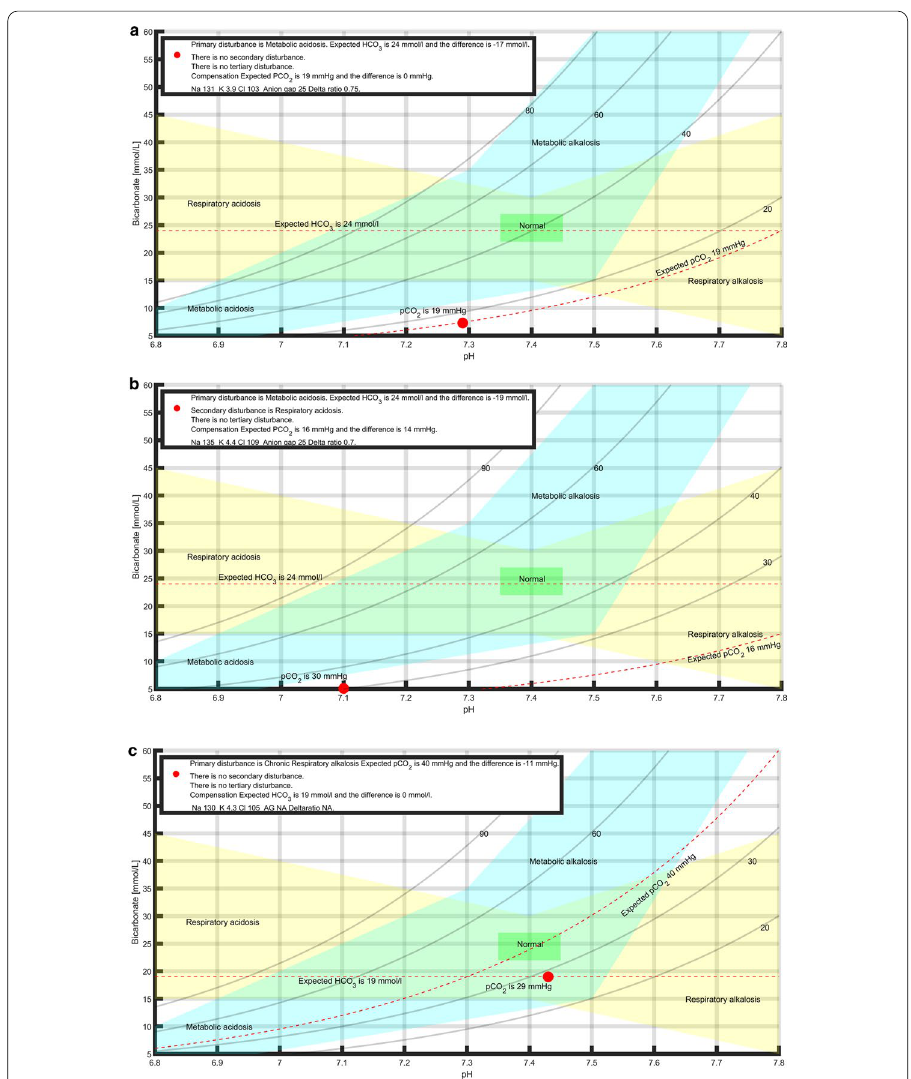
Fig. 1 A Primary disturbance is a metabolic acidosis and the deviation from baseline is 17 mmol/L. − The compensation is full with a hyperventilation resulting in a pCO 2 of 19 mmHg. The script uses Boston formulas. The graphic output shows the low bicarbonate and the low pCO 2 levels, as well as the pH which has been compensated close to normal. B Primary disturbance is a metabolic acidosis and the deviation from baseline is 19 mmol/L, which equals a critical metabolic acidosis. However, in this case, there is a secondary − respiratory acidosis disturbance making it impossible for the patient to hyperventilate the pCO 2 down to 16 mmHg, which would be a complete compensation. Instead, the pCO 2 has remained at 30 mmHg level. This means that the compensation is 10 mmHg (equals actual compensation [40–30] mmHg against full = compensation [40–16] mmHg and thus 42 percent). C Primary disturbance is a chronic respiratory alkalosis = and the deviation from baseline is 11 mmHg. Because the compensation overshoots the level of full − compensation for acute respiratory alkalosis, which would equal a bicarbonate level of 22 mmol/L (instead it is 19 mmol/L) the disturbance is chronic. In fact this equals full compensation for chronic disturbance and the script thus returns that the primary respiratory alkalosis disturbance is chronic, fully compensated and that no secondary disturbance is identified. Also, the pH is within normal range. D Primary disturbance is a metabolic acidosis with a deviation from the baseline of 18 mmol/L, with an elevated anion gap of 19. The − script returns a secondary disturbance of a respiratory acidosis, because the compensation is not full; there is a 8 mmHg difference (actual pCO 2 value is 25 mmHg) to full which would be 17 mmHg. In this case the delta ratio is calculated to 0.39, which indicates a tertiary disturbance. The [Na + –Cl − ] difference is 18 mmol/L and the script returns a suggestion of a tertiary disturbance as a hyperchloremic